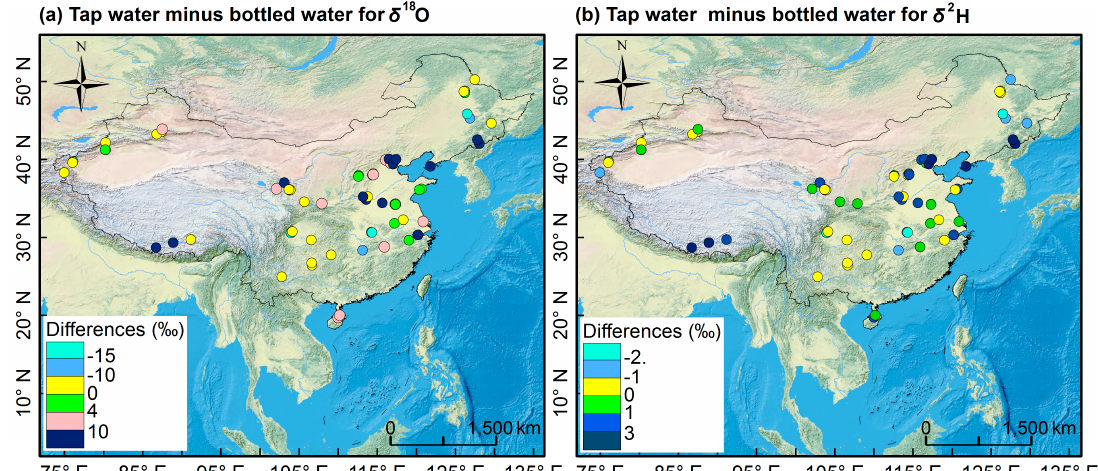
Figure 9. Correlation between δ 2 H ( a ) and δ 18 O ( b ) in bottled water and local tap water. From the tap water database provided by [27], 80 stations of tap water (Figure 1) adjacent to the origin of bottled water sites were examined. The dotted line is the line of equality (y = x).